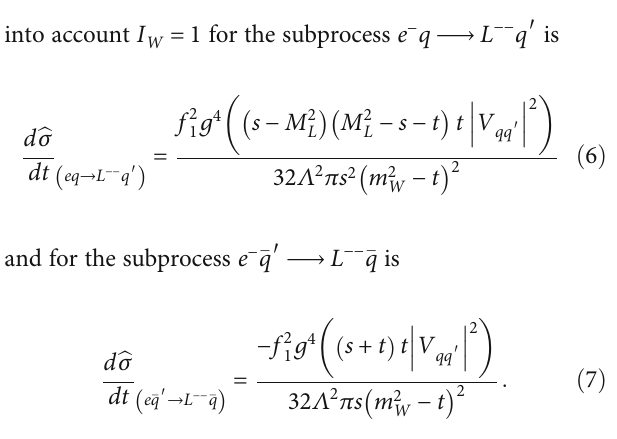
Figure 8: Invariant mass distribution of ejj system for I